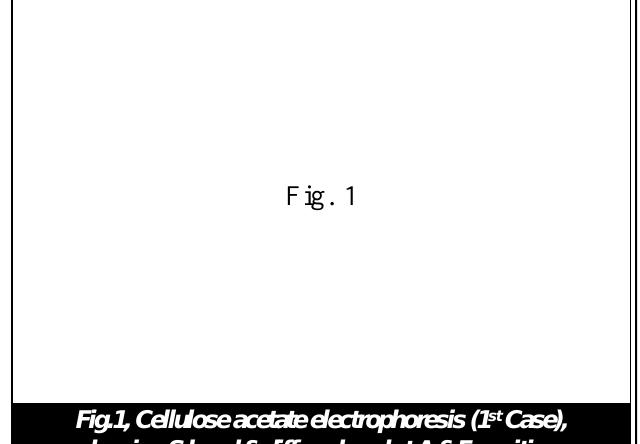
showing S band & diffuse band at A & F